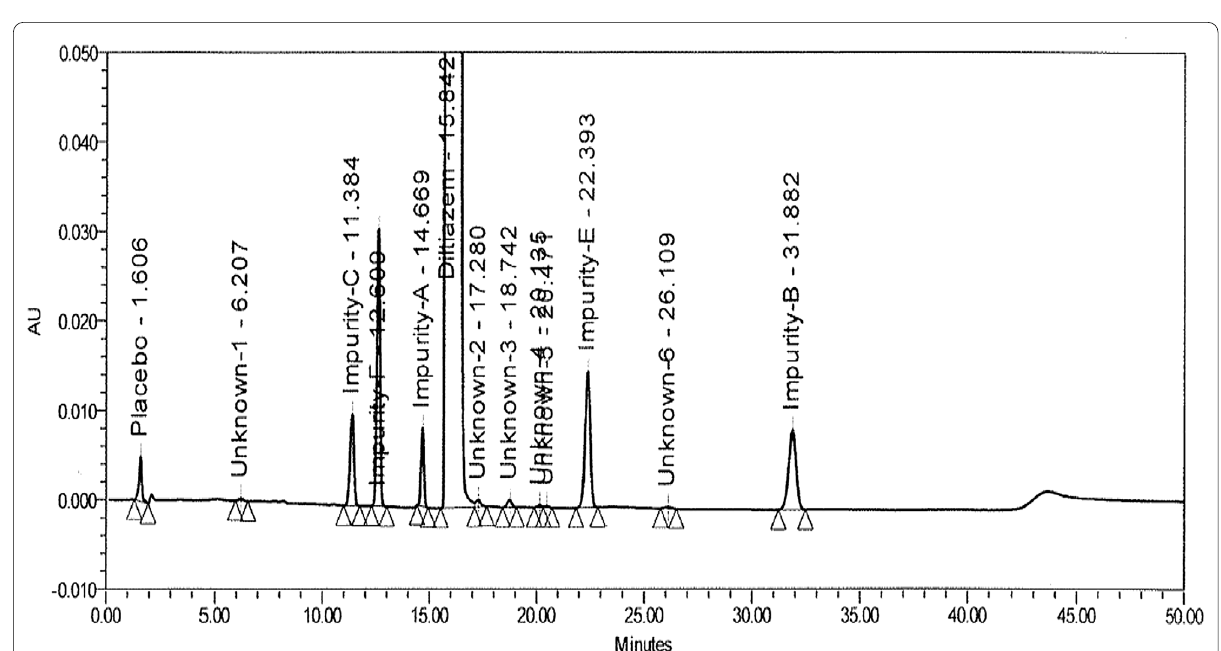
Fig. 10 Typical HPLC chromatogram of spike